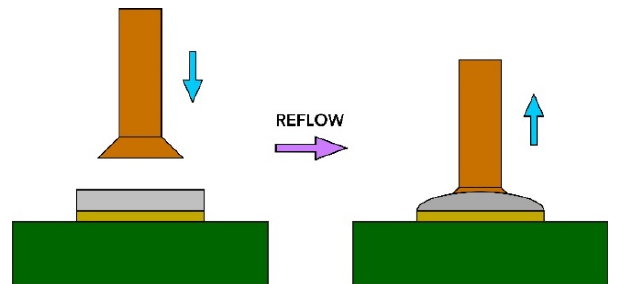
Figure 4. Testing method—rivet mounting.